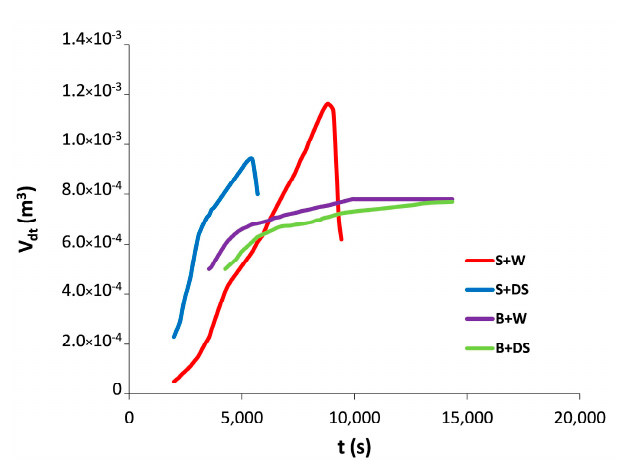
Figure 9. Total volume of liquid displaced from the porous media to the tray. Porous media based on sand (time up to 500 s after dryout). Porous media based on bronze (all experimental time).